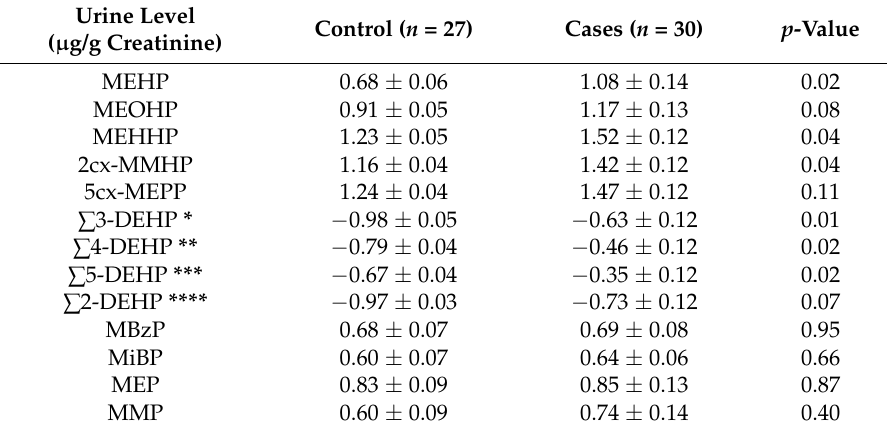
Table 3. The log transformed creatinine-adjusted urinary phthalate levels in cases and controls. Urine